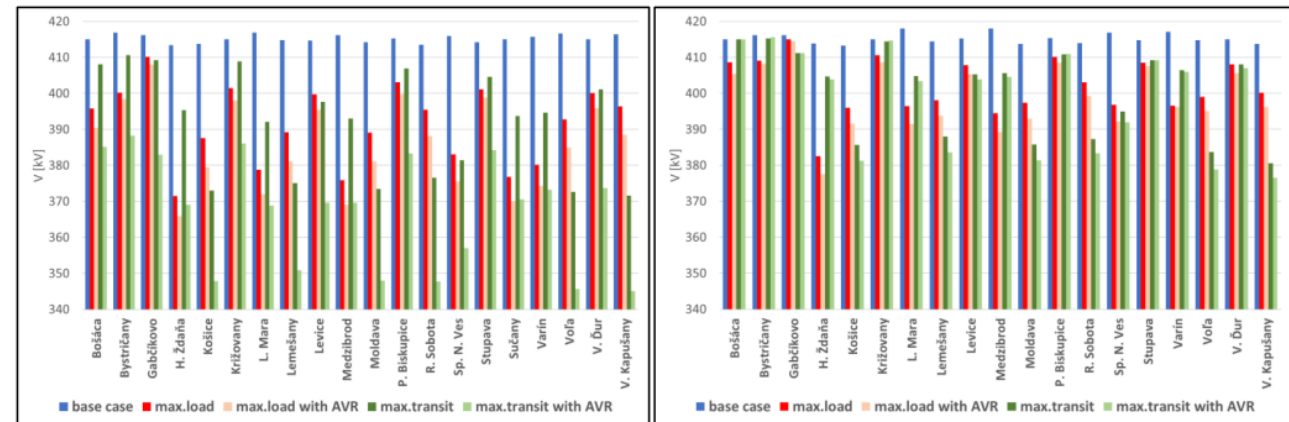
Figure 5. Voltage in 400 kV TS substations: winter (left), summer (right).